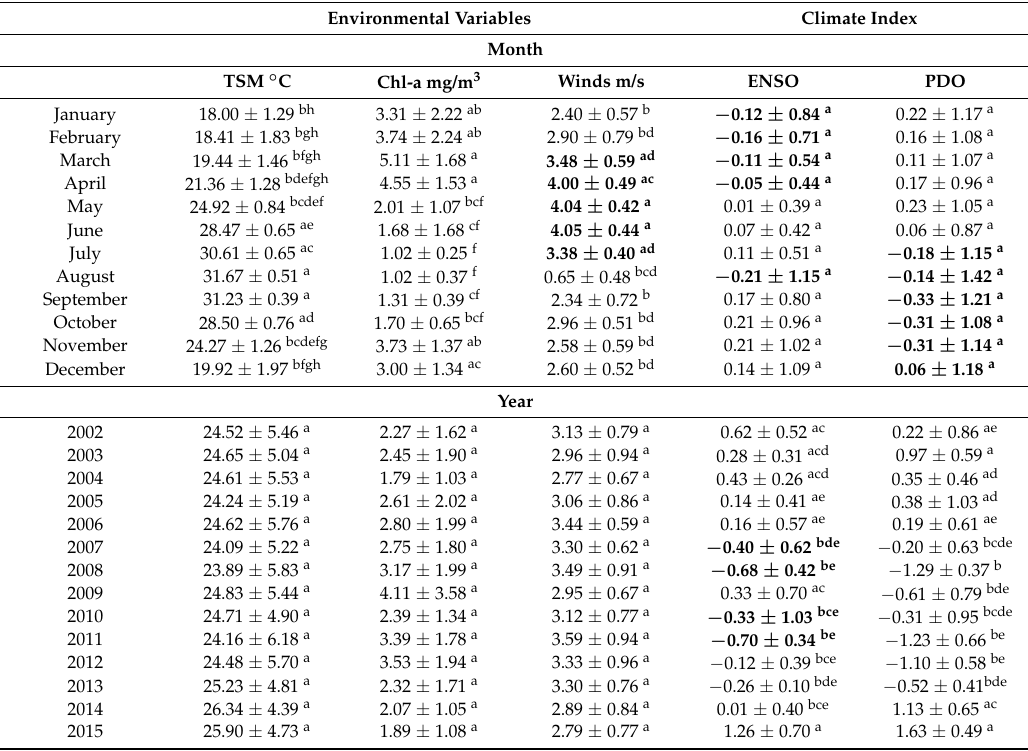
Table 4. Monthly and annual analyses of temperature, chlorophyll a, winds and climate indexes of the El Niño Southern Oscillation and Pacific Decadal Oscillation in the central and southern coastal regions of Sonora and adjacent deep zone in the Gulf of California, Mexico, from